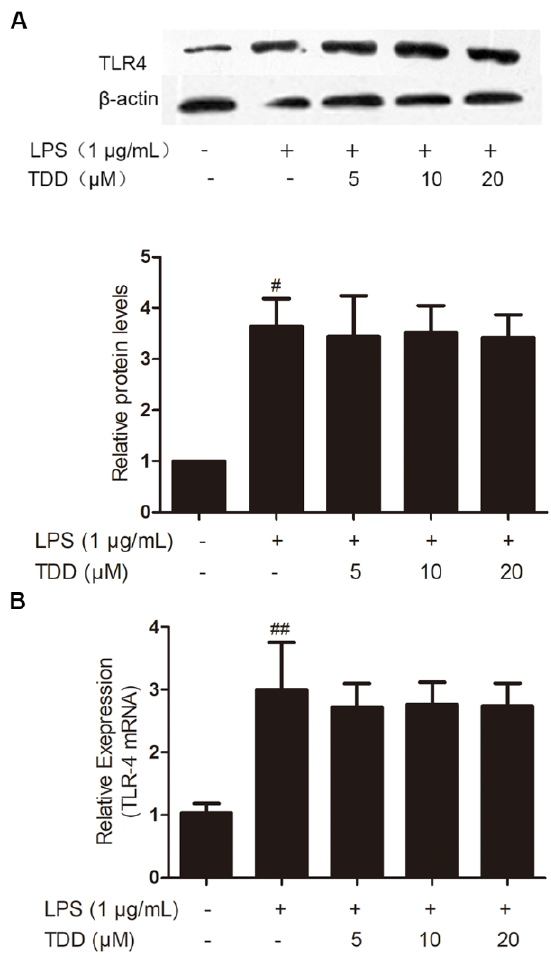
Figure 1. Effects of TDD on the expression of TLR4 in LPS-stimulated EA.hy926 cells. EA.hy926 cells were treated with various concentrations of TDD (5, 10, and 20 µ M) for 4 h, and then LPS (1 µ g/mL) was added for 12 h. ( A ) protein levels, and ( B ) mRNA levels. The data show the mean ± S.D. of three independent experiments. # p < 0.05 and ## p < 0.01, compared to the LPS ( − ) TDD ( − ) group.